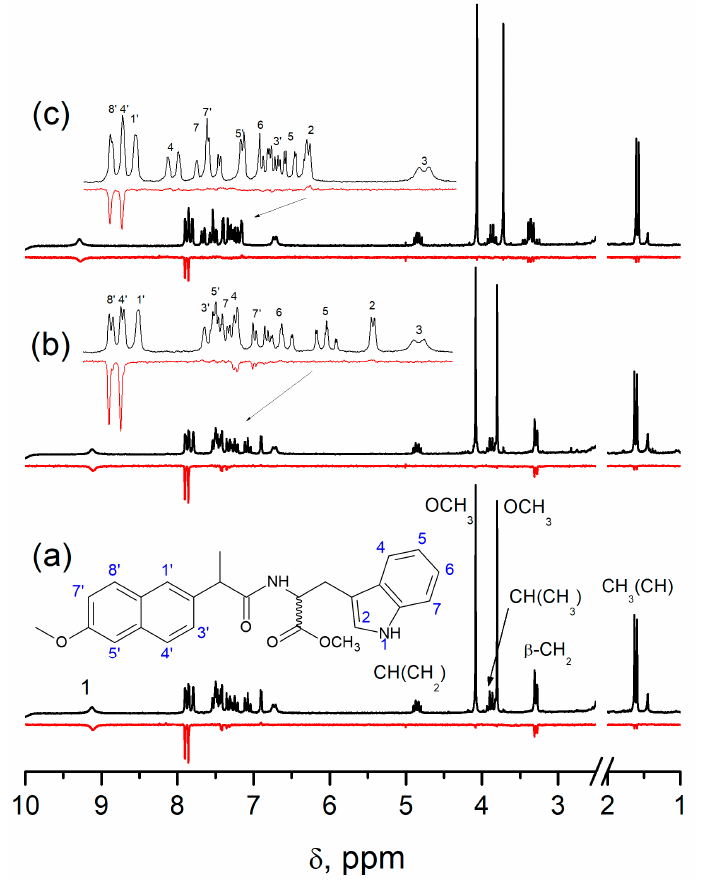
Figure 11. 1 H NMR (black) and CIDNP spectra (red) of 5 mM solutions of ( a ) ( R,S )-III, ( b ) ( S,R )-III, and ( c ) ( S,S )-III in CD 3 CN. Inserts show the expanded region of resonance for aromatic protons.